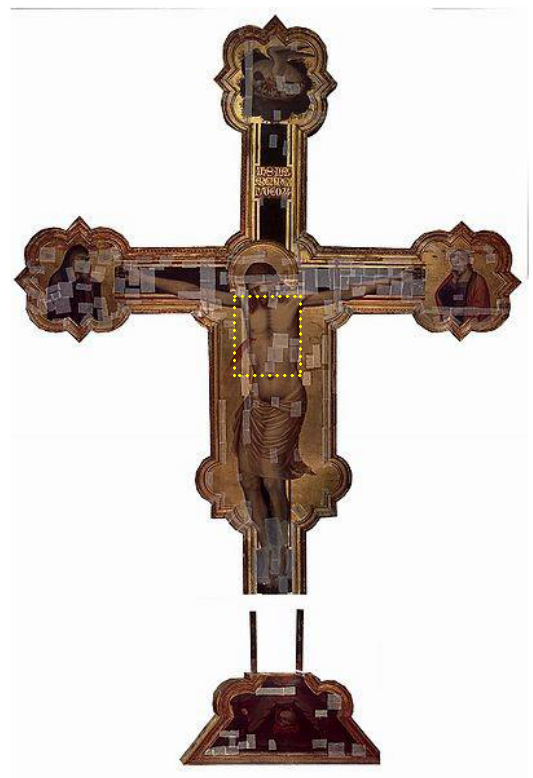
Figure 30. Croce di San Marco.